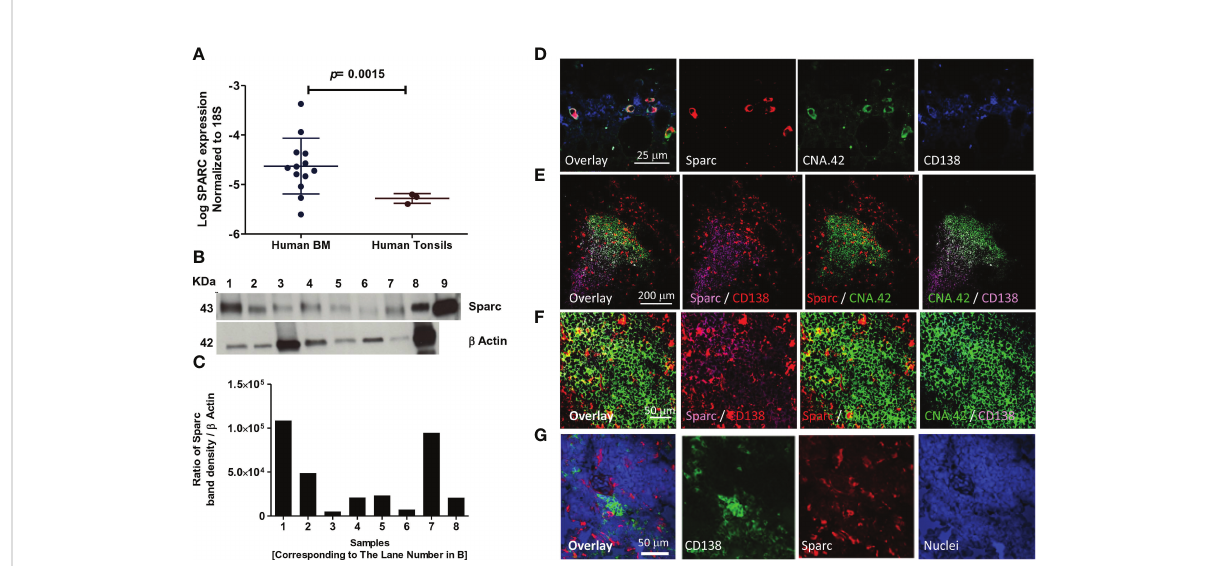
FIGURE 2 Expression of SPARC in normal human (primary and secondary) lymphoid tissues. Log SPARC expression level in normal human BM of 13 control patients (n = 13) and normal human tonsils (n = 3). (A) Western blotting of SPARC; b -actin was used as internal loading control, and an equal amount (15 m g) was loaded per lane. Lanes 1 – 7; BM tissue of seven control patients; 8, human tonsil; 9, human recombinant SPARC protein 5 ng (positive control) (B) . SPARC relative quantitation to b -actin using ImageJ; ratio of SPARC band density/ b -actin band density (C) . Confocal imaging of SPARC (red), CNA42/FDCs (green), and CD138/PCs (purple) in normal human BM (D) and normal human tonsil (E) . Follicular GC light zone of tonsil at higher magni fi cation (F) . The dual-color overlay of SPARC and FDCs (colocalization giving yellow/orange color; SPARC secretion from FDCs in the BM/tonsils), SPARC and CD138, and FDCs and CD138 (colocalization in GC light zone gives a white color) are shown. The triple-color overlay of SPARC, FDCs, and CD138 is shown, and the dark zone of the GC shows the PC differentiation. Confocal imaging of the SPARC (red), CD138 (green), and nuclear staining (blue) in normal human tonsil (G) . Sections are shown in three separate channels, and triple-color overlay of SPARC, CD138, and nuclei is